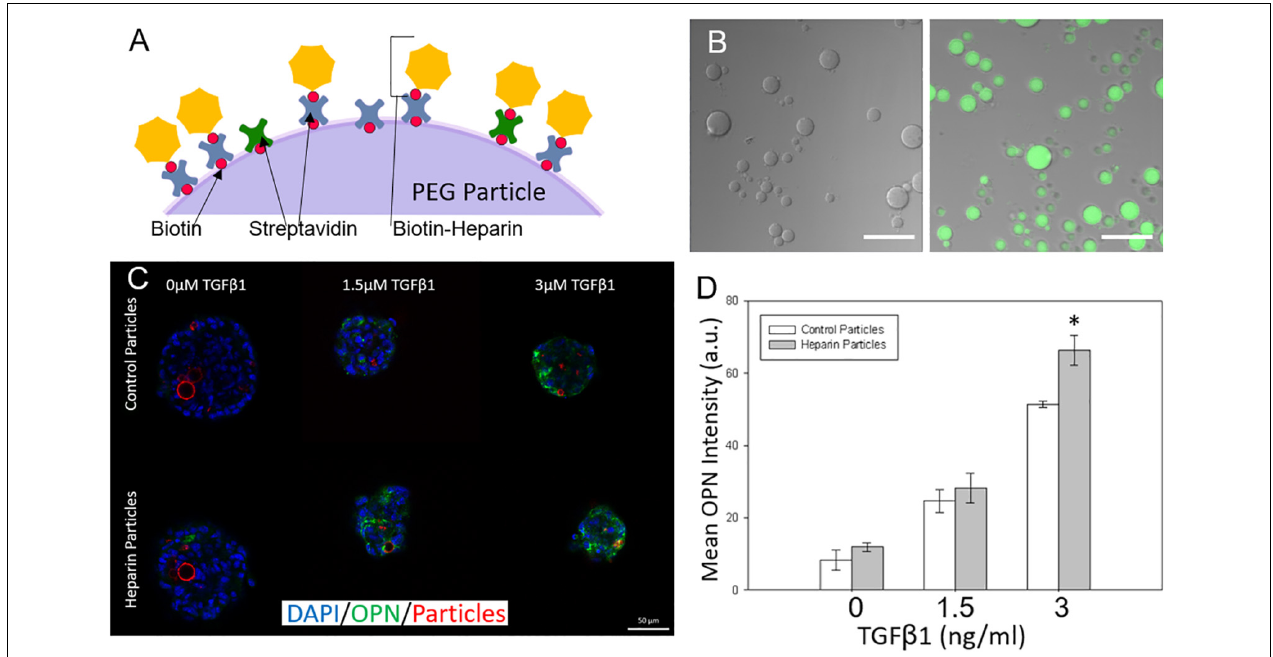
FIGURE 5 | Adding surface conjugated heparin to microparticles to tune liver differentiation. (A) Biotinylated heparin is conjugated to the PEG particle surface via a biotin-streptavidin-biotin bridge. (B) Heparin presence on PEG particles was verified by conjugating AF488 fluorescent heparin to particles and imaging. (Left) control particle without heparin addition. (Right) AF488-heparin conjugated to particle. Scale Bars: 50 µ m (C) Heparin and control particles integrated into Aggrewell spheroids and exposed to different levels of TGF β 1 (Blue: DAPI; Green; OPN; and Red: AF647-PEG particles) (D) Mean OPN intensity for Aggrewell spheroids with the 2 particle